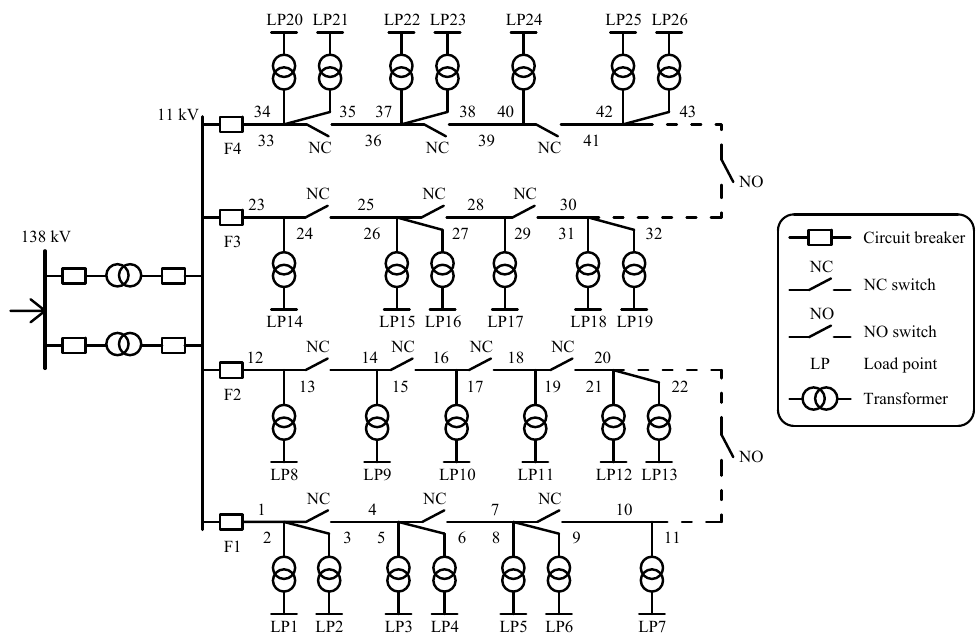
Figure 6. Distribution network at bus 5 of the RBTS [29].